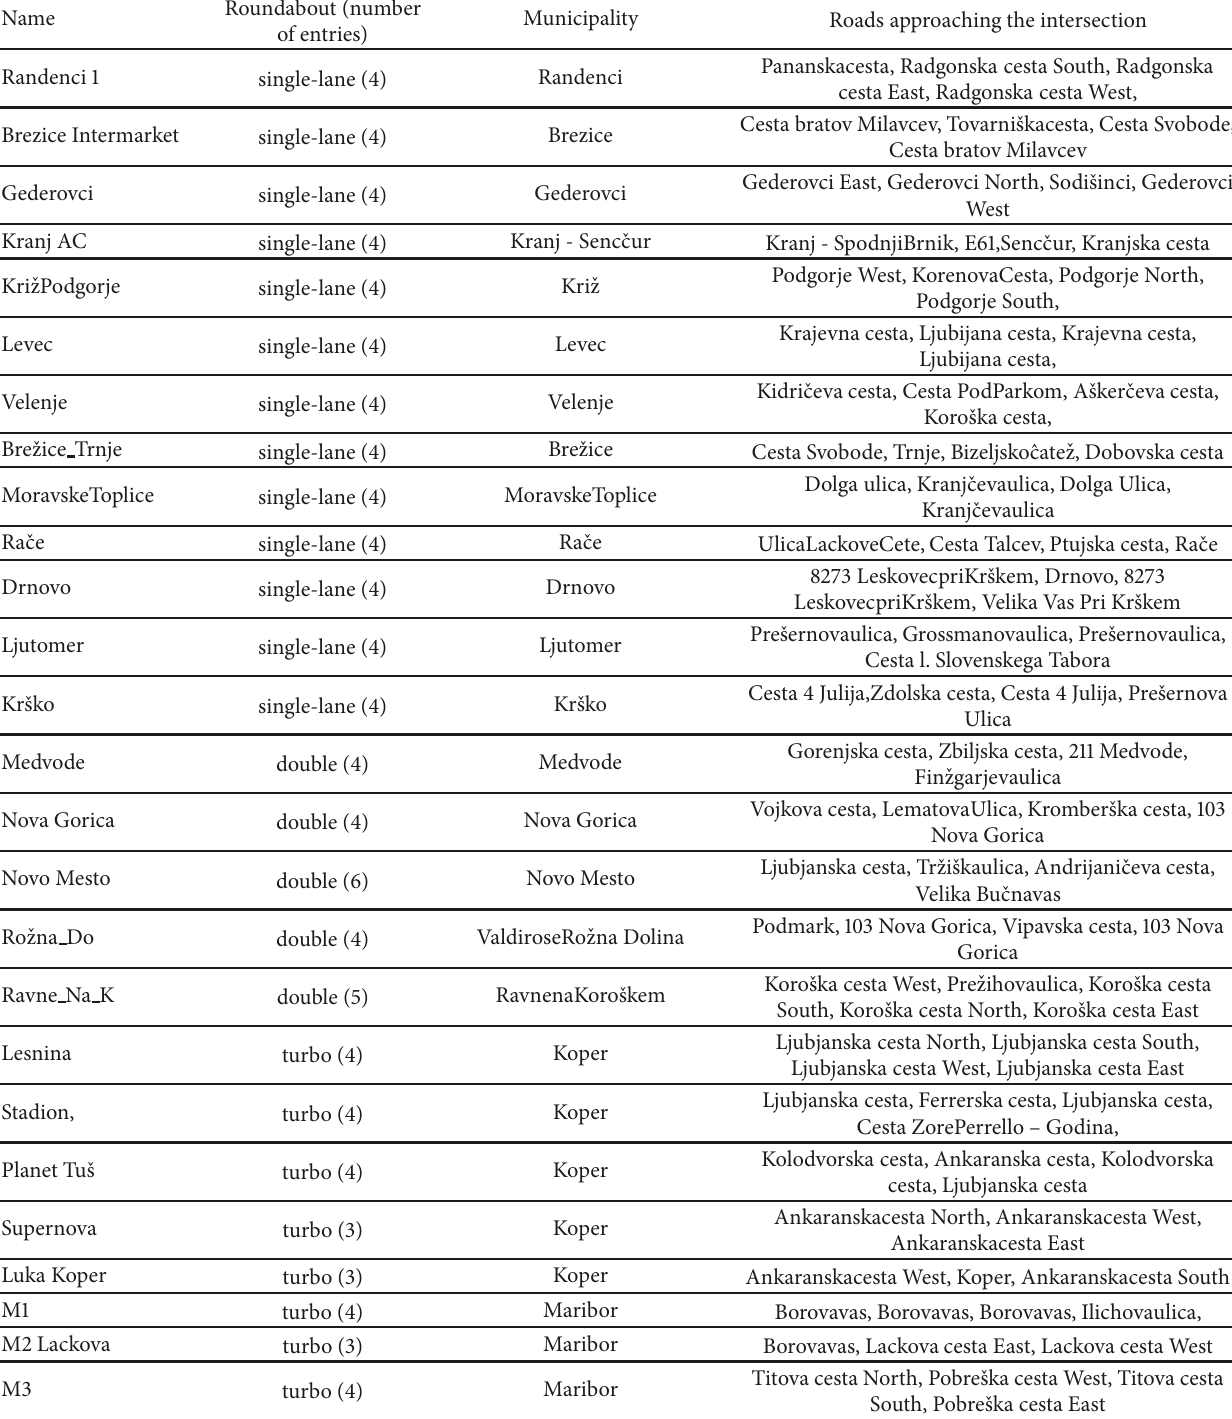
Table 1: Information on the roundabouts case studies from Police